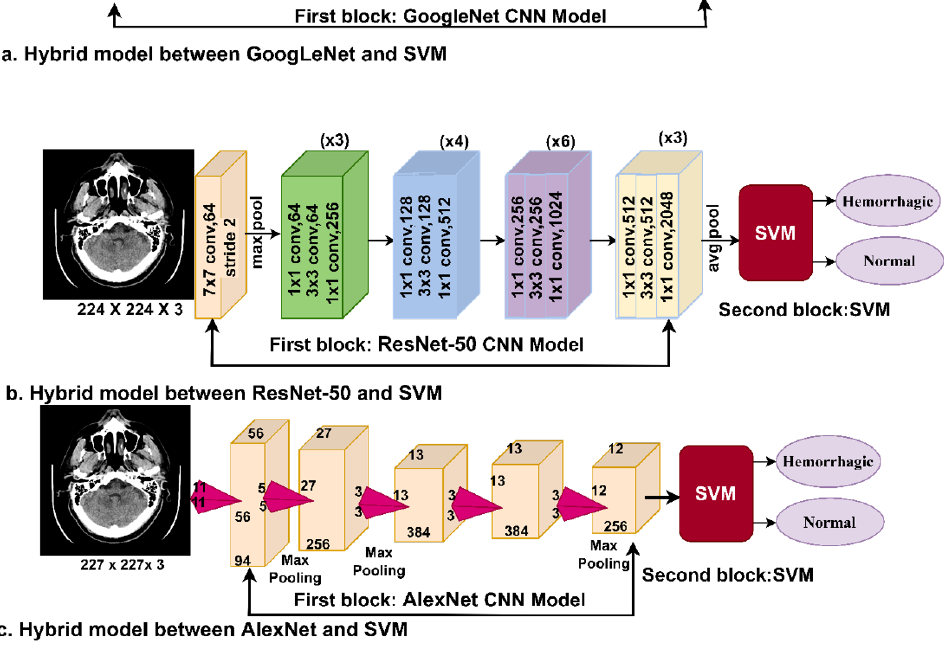
Figure 5. Hybrid methodology between deep learning and SVM. ( a ) GoogleNet+SVM. ( b ) ResNet-50 + SVM. ( c ) AlexNet +